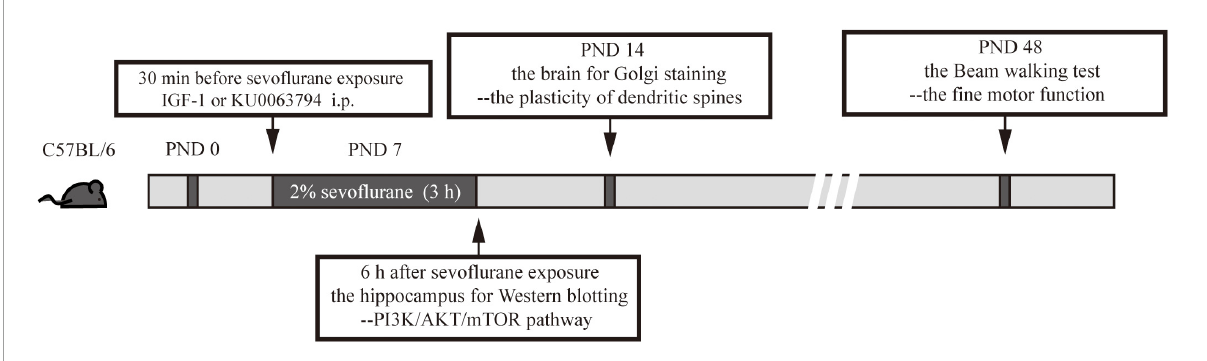
FIGURE1 The overall experimental procedures in this study.